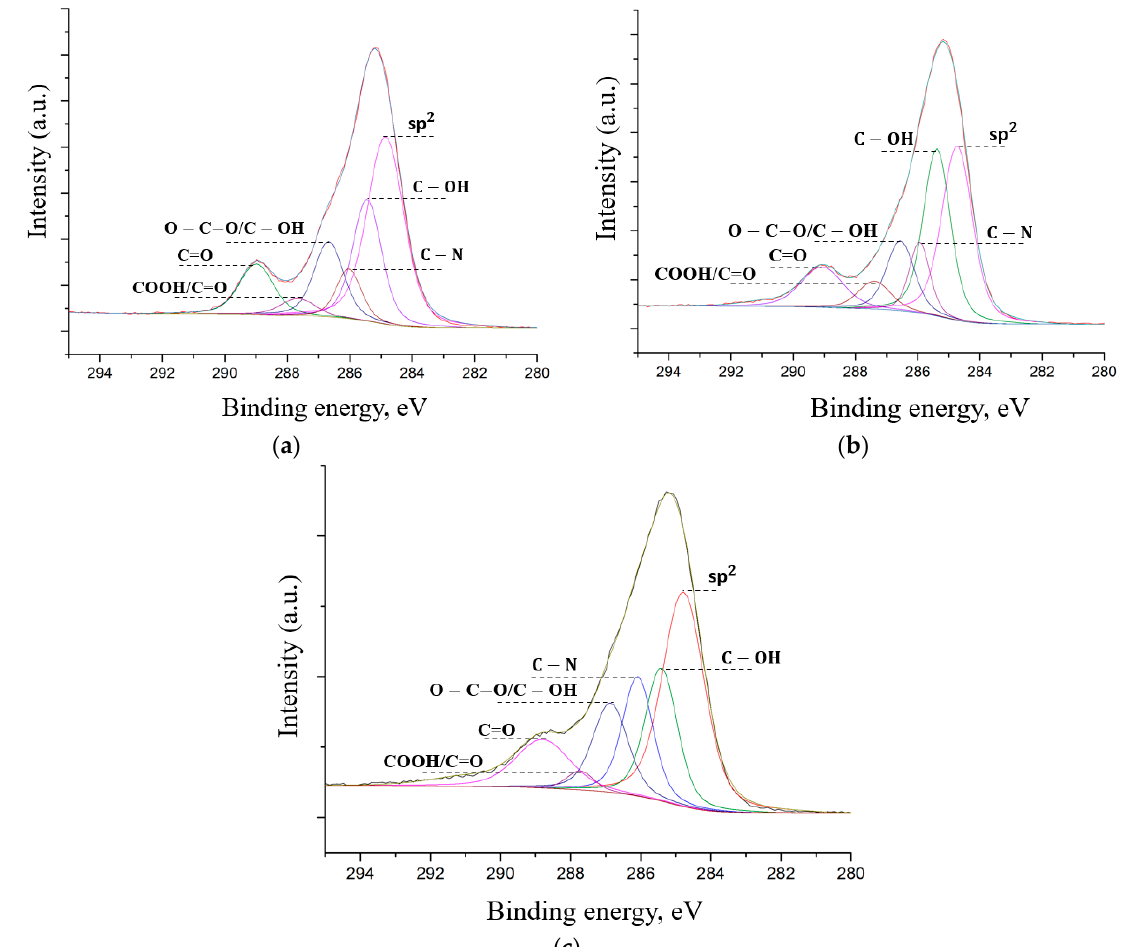
Figure 9. XPS spectra of FLG nanosheets. ( a ) glucose,( b ) starch, ( c ) cellulose.